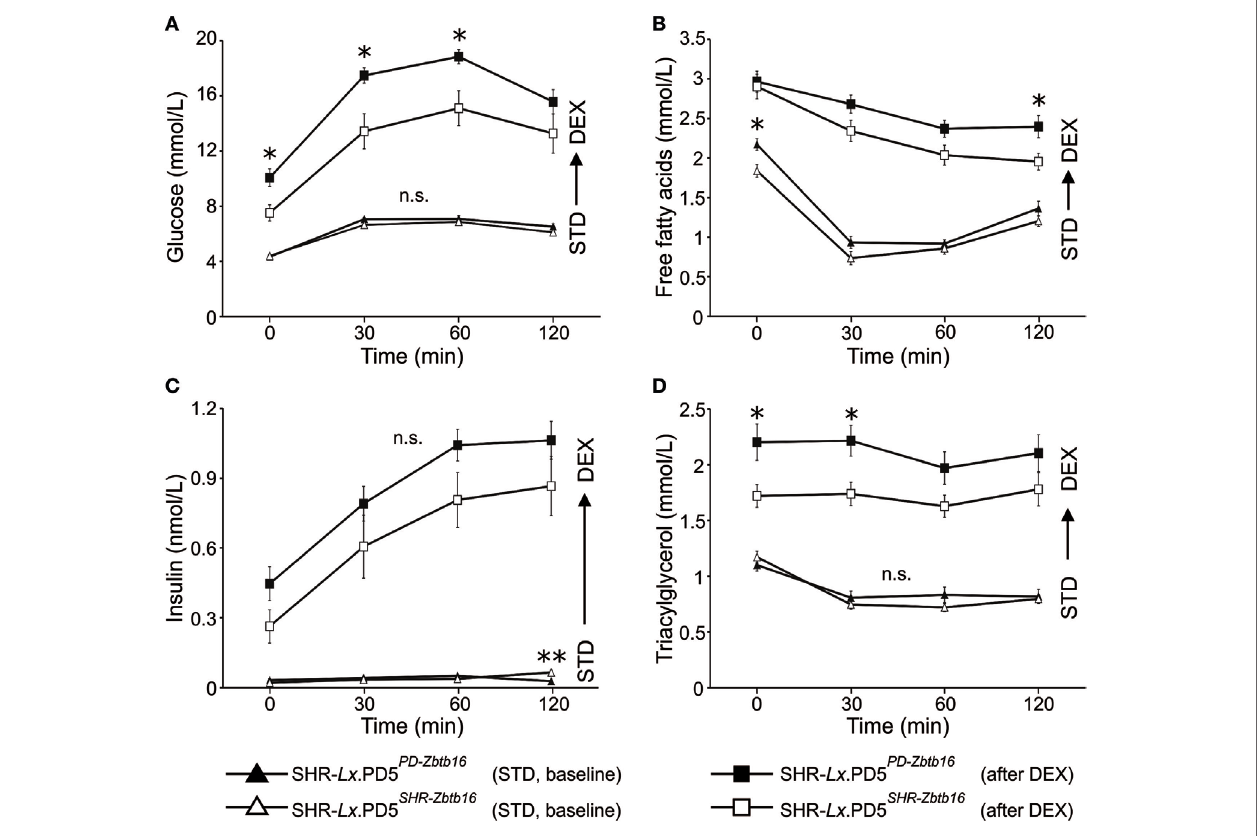
FigUre 2 | The oral glucose tolerance test (OGTT). Time course of glucose (a) , free fatty acids (B) , insulin (c) , and triacylglycerols (D) during OGTT is shown for standard diet-fed SHR- Lx .PD5 PD- Zbtb16 (black triangles, n = 9) and SHR- Lx .PD5 SHR- Zbtb16 (open triangles, n = 8) male rats. The procedure was then repeated in the same animals after administration of dexamethasone (values for SHR- Lx .PD5 PD- Zbtb16 shown as black squares, SHR- Lx .PD5 SHR- Zbtb16 shown in open squares). Adjusted statistical significance levels using the repeated measured ANOVA are indicated for differences between the strains under identical conditions as * P <